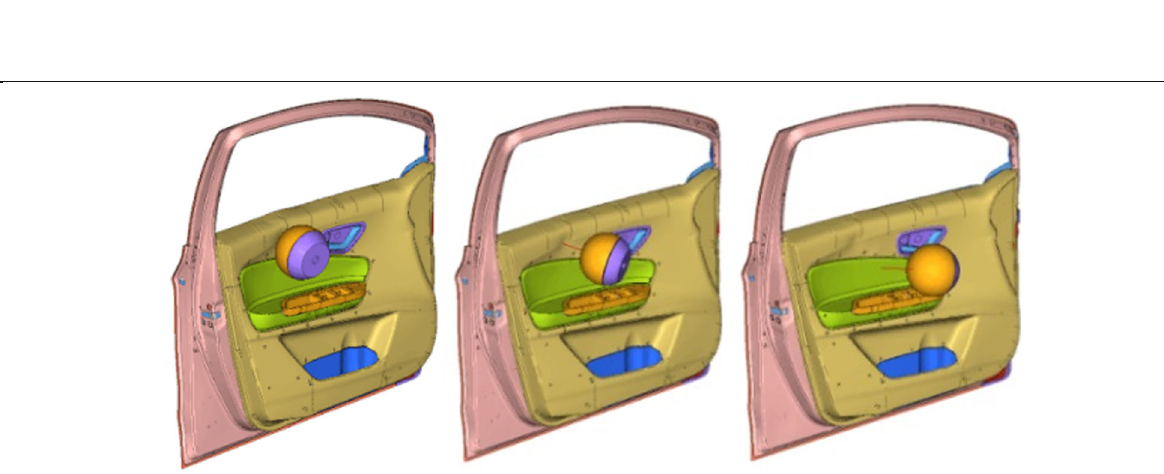
Fig. 14 The rider-car door collision process without the airbag protection at the opening angle of